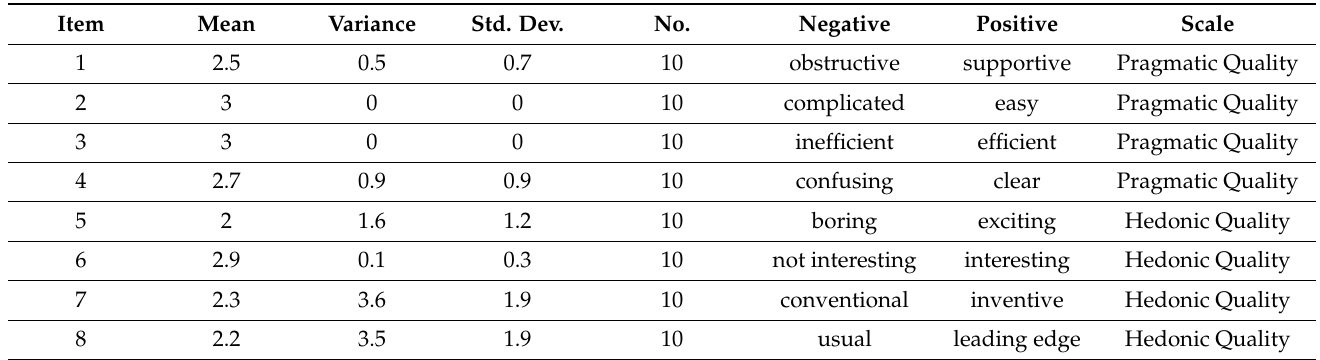
Table 1. Workers’ answers to the UEQ-S.